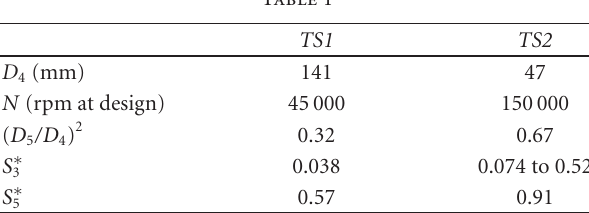
ψ and φ follow. To avoid perturbation of